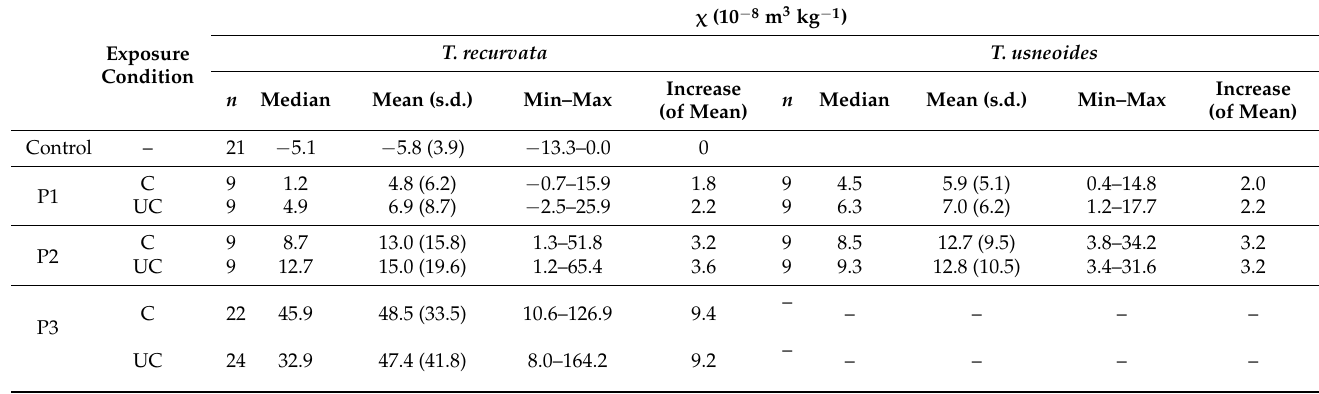
Table 2. Measurements of magnetic susceptibility χ of Tillandsia recurvata and Tillandsia usneoides for exposure periods and cover (C) and uncover (UC) exposure